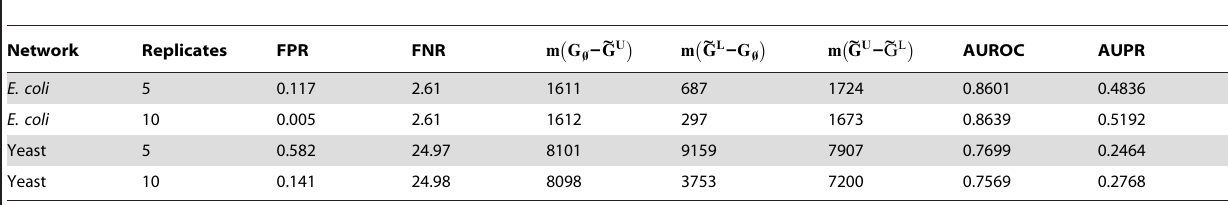
Table 9. Ensemble inference of E. coli and Yeast GRNs from single-gene KO data.